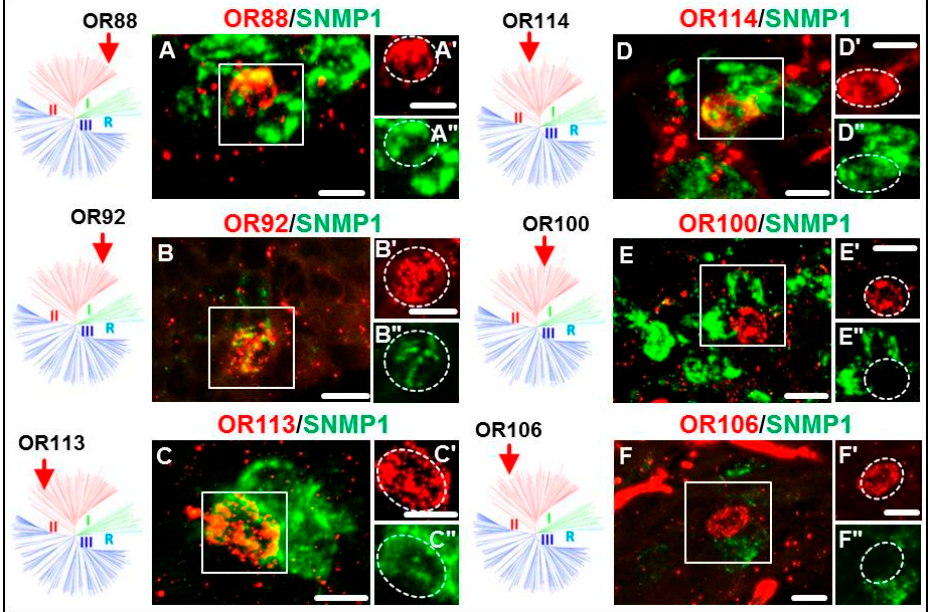
Figure 4. Expression of SNMP1 and group II SgreORs with an orthologues sequence. ( A–F ) Two-color FISH on sections through the antenna of S. gregaria incubated with antisense probes for SNMP1 (green) and selected SgreOR types (SgreOR88, SgreOR92, SgreOR113, SgreOR114, SgreOR100 and SgreOR106) that have an orthologue in L. migratoria . ( A’–F’, A’’–F’’ ). Higher magnifications of the boxed regions in A–F are depicted for the red and the green fluorescence channel. The broken lines denote cells that express the relevant SgreOR types. While cells positive for SgreOR88, SgreOR92, SgreOR113 or SgreOR114 co-express SNMP1, cells expressing SgreOR100 or SgreOR106 are negative for SNMP1. Scale bars, 10 μ m. The arrows in the schematic representations of the phylogenetic tree mark the position of the relevant SgreORs.